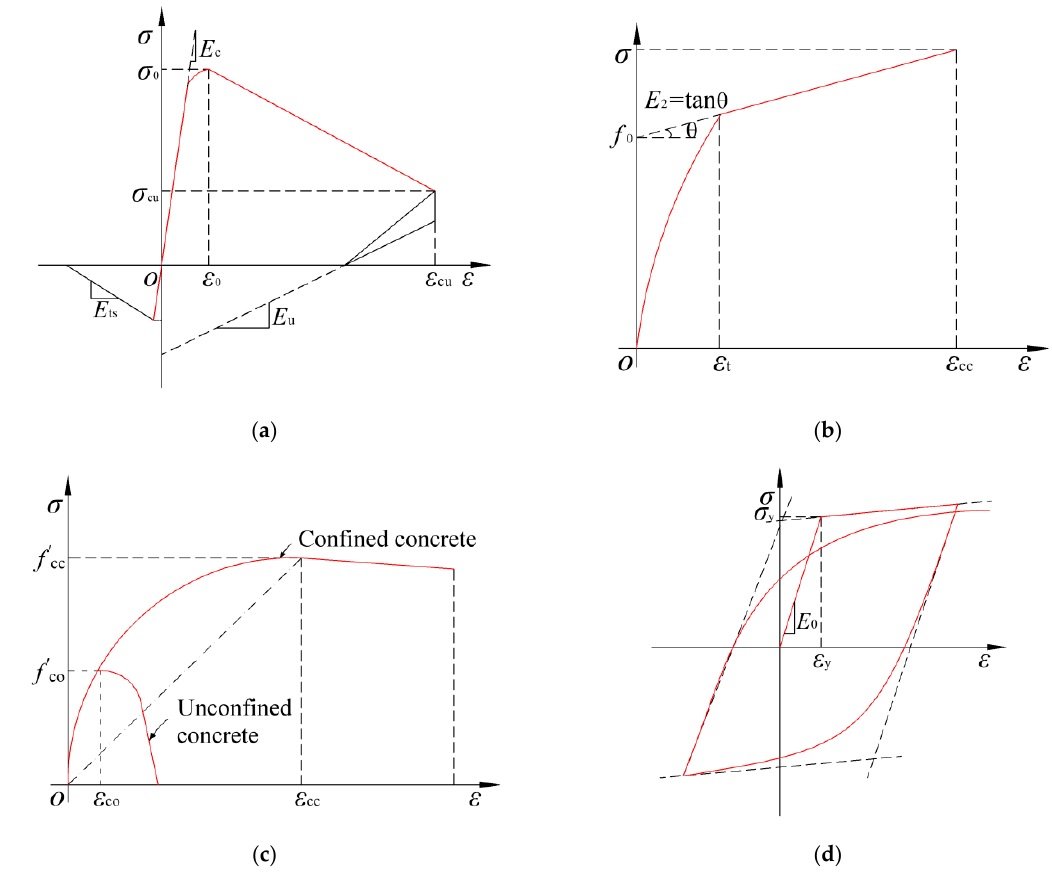
Figure 14. Material models. ( a ) Concrete02 model. ( b ) PVC-FRP confined concrete. ( c ) Joint core concrete. ( d ) Steel02 model.